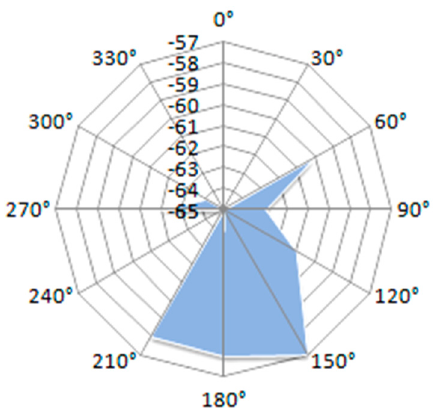
Figure 19. RSSI level vs. node orientation in a face-to-face measurement setup.